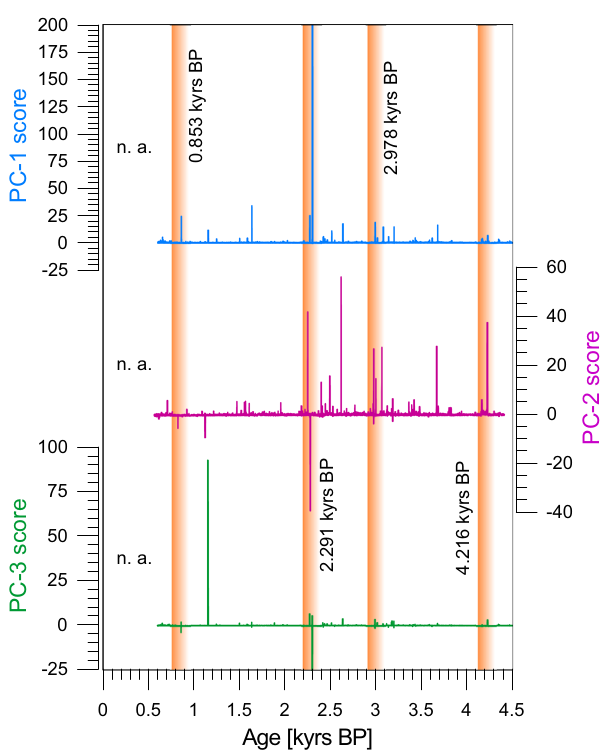
Fig. 6 Scores of the principal components PC-1, PC-2, and PC-3 performed on the LA-ICP-MS data set (S, P, U, Si, Sr, and Zr). The PCA scores of PC-1, PC-2, and PC-3 are shown for the time span from 4.5 to 0.6 kyrs BP. The section labeled with n.a. has not been analyzed. Orange bars mark periods in which the PC main spikes are synchronous with compositional trace element peaks at 4.216, 2.978, 2.291, and 0.853 kyrs BP (Figs. 3 –